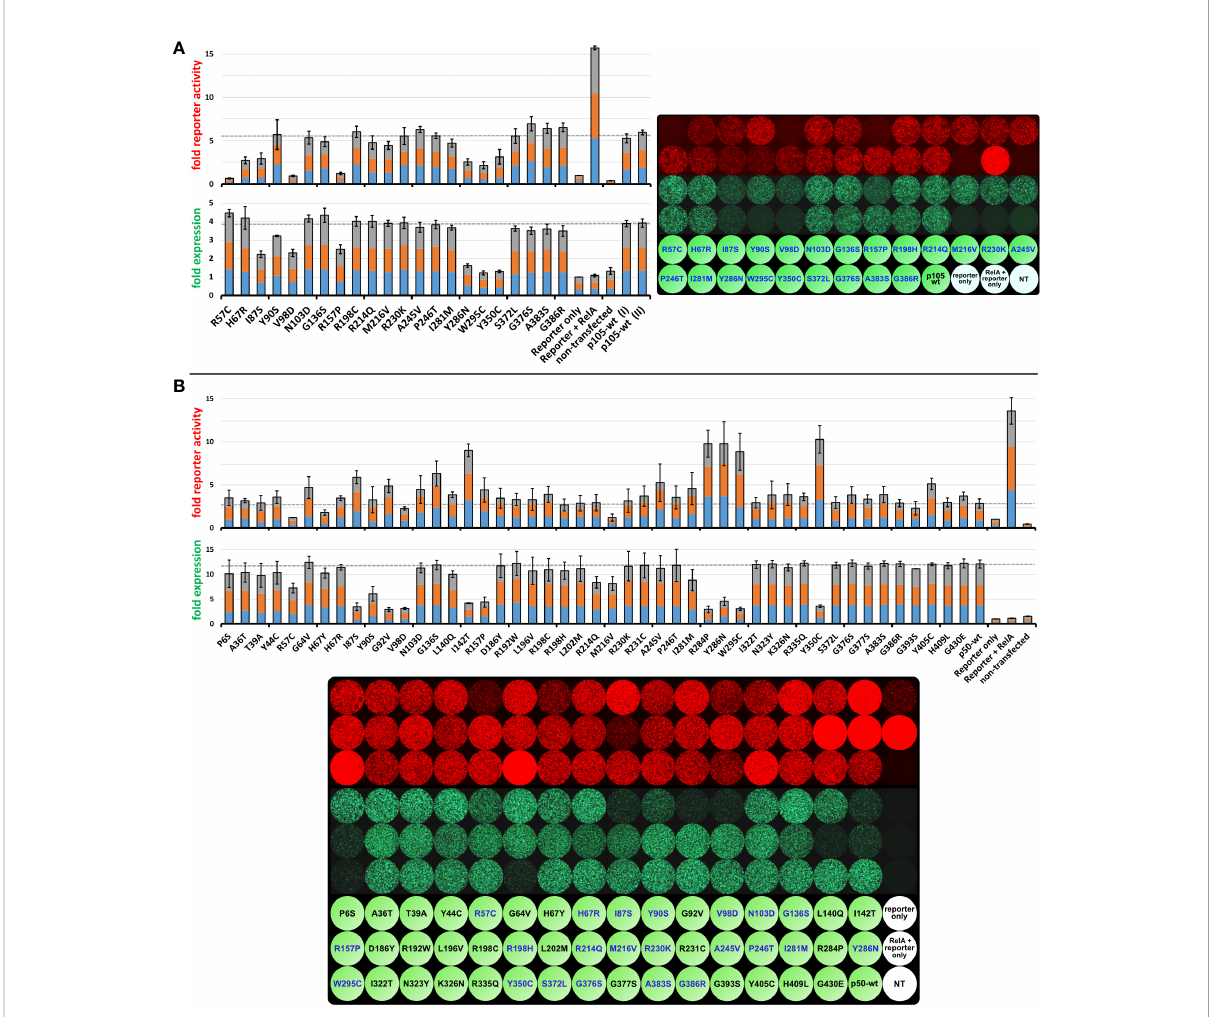
FIGURE 5 The inhibitory effect on RelA-dependent promoter activation can be augmented by co-expression of mutant p105 but can either be attenuated or intensi fi ed by mutant p50. HEK293T cells were transiently transfected with a synthetic reporter gene construct (100ng), composed of an NF- k B responsive promoter driving the expression of the red fl uorescent protein tdTomato. Reporter expression was switched on to maximum levels by co-expression of RelA (5 to 7.5ng vector). An excess of wildtype or mutant EGFP-p105 or EGFP-p50 expression vectors (300ng each; green fl uorescence) was added to inhibit the RelA-mediated reporter activation. Expression of the reporter gene and the p105- or p50 fusion constructs was monitored at 48h (not shown) and 72h after transfections by recording the red (4-8 scans per plate) and green (3-6 scans per plate) fl uorescence intensities, respectively. Average fold values were calculated from three independent experiments with the baseline intensities of the “ reporter only ” controls set as 1-fold. Each color in the three-colored bar graphs indicates one experiment (proportional illustration, no absolute values). Microscopic images show one representative example of the three independent experiments each. The full panels with absolute reporter activity and expression values for each variant are shown in the Supplementary Figures 2-3 and Supplementary Table 2. (A) Moderate RelA-dependent reporter activity is observed with co-expression of wildtype p105. Decreased reporter expression upon co-expression of mutant p105 compared to wildtype p105 indicates protein defects and might be due to less or absent processing to p50 and/ or cytoplasmic retention of RelA by mutant p105, respectively. Average values were calculated from three independent experiments using 5ng, 6ng and 7.5ng of the RelA vector, respectively. (B) Co-expression of wildtype p50 limits the RelA-dependent reporter activation, probably due to the assembly of excess homodimeric transcriptional repressors. Defects of p50 caused by single amino acid changes are indicated by either reduced or increased reporter activation compared to wildtype p50 and might be due to less expression, loss of DNA binding activity or other defects. Average values were calculated from three independent experiments using 5ng RelA vector